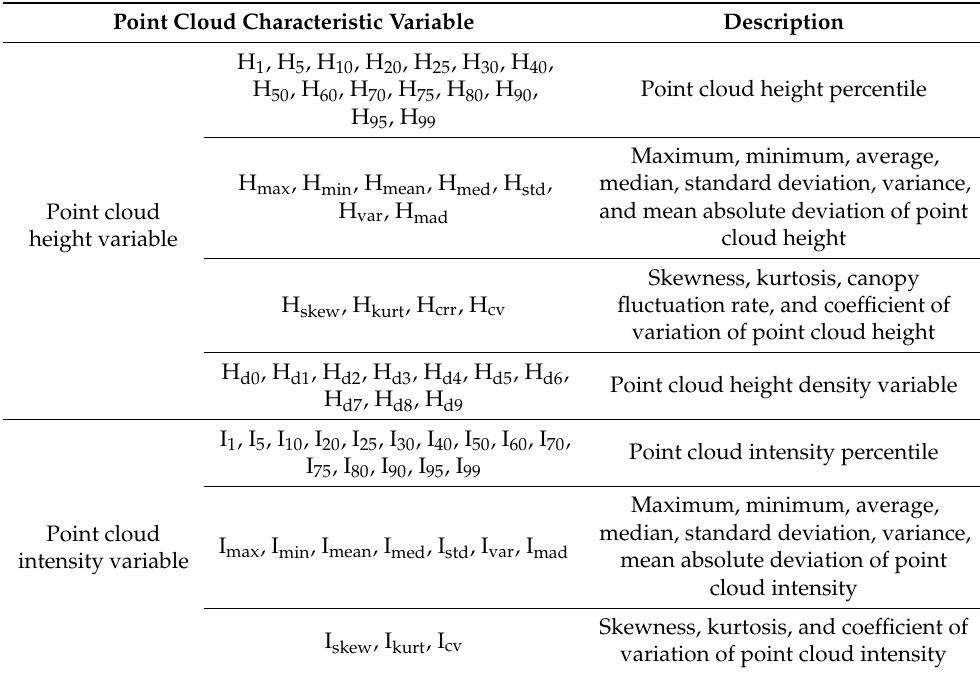
Table 3. Extracted point cloud characteristic variables